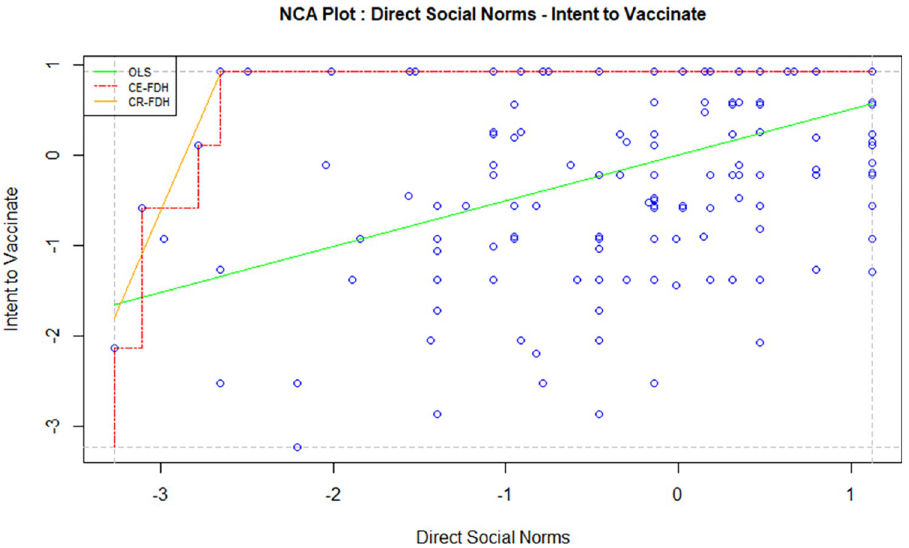
Fig 3. NCA (direct social